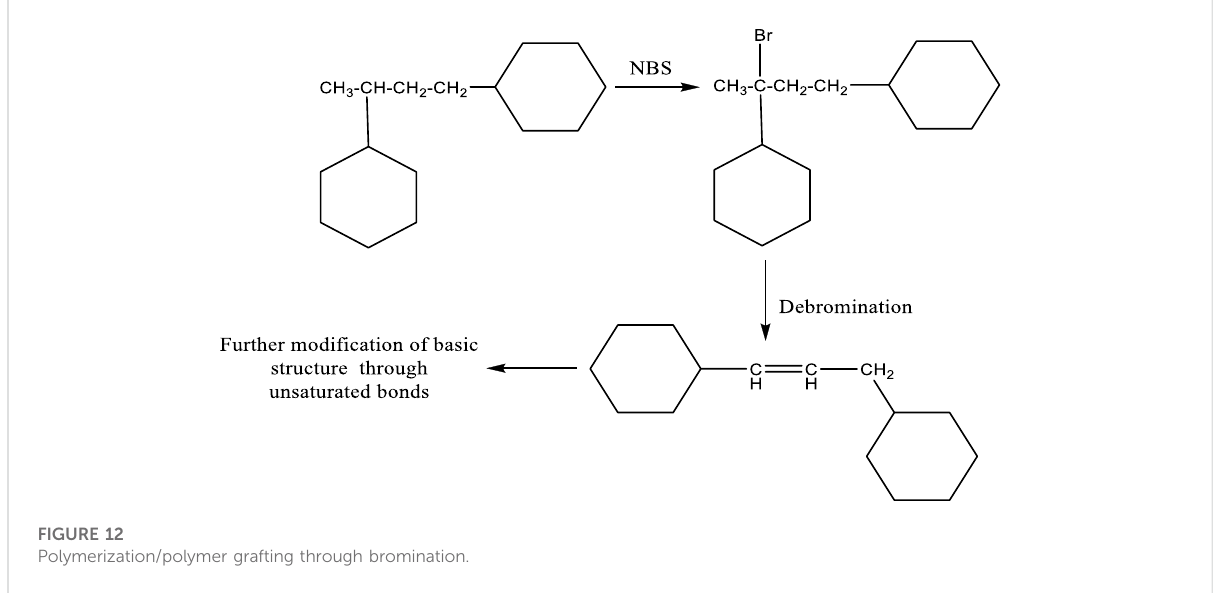
FIGURE 12 Polymerization/polymer grafting through bromination.